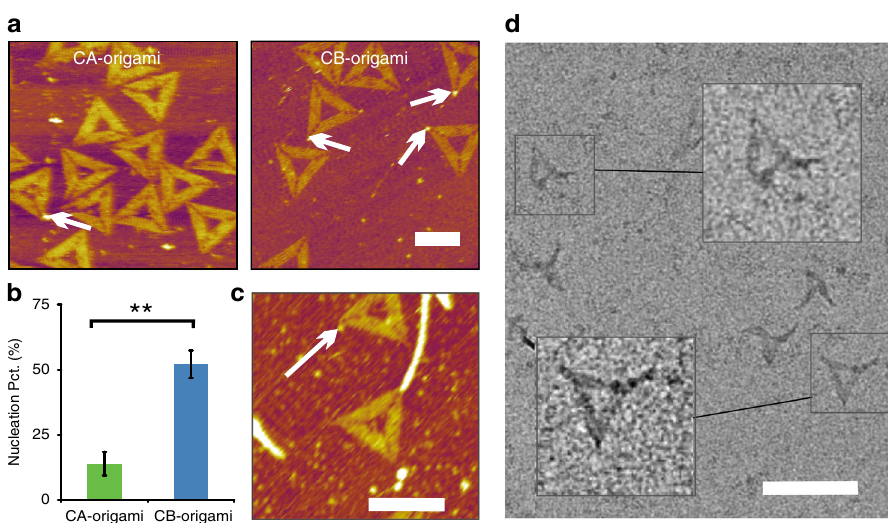
Fig. 2 Probing the nucleation roles of CsgB in CsgA polymerization with CB-origami. a AFM height image of the formed oligomers (3.2 ± 0.3 nm in height) at the vertex of CA-origami and CB-origami, respectively (with 1.0 μ M CsgA monomers). b Comparison of the nucleation ef fi ciency between CB-origami (52.6 ± 5.3%) and CA-origami (14.3 ± 4.6%) by calculating the percentage of origami tethered with dot-like oligomer structures at the vertex (with 1.0 μ M CsgA monomers); the data were collected by counting 100 origami structures for each group. All data points were averages of three independent experiments ( n = 3) and presented as the mean ± standard error of the mean (s.e.m). ** P < 0.01, two-tailed two-sample t -test. Source data are provided as a source data fi le. c , d AFM height and TEM images showing fi bril (3.4 ± 0.4 nm in height) growing directly from the vertex of the CB-origami (with 2.0 μ M CsgA monomers). The white arrows refer to the dot-like oligomers formed at the vertex. Scale bars: 100 nm. Note: AFM imaging was purposely carried